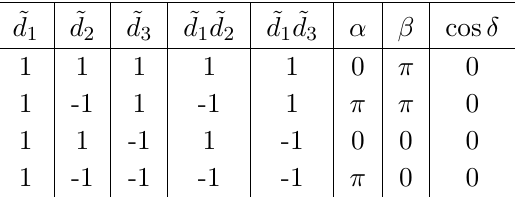
Table 1 . Predictions on the CP